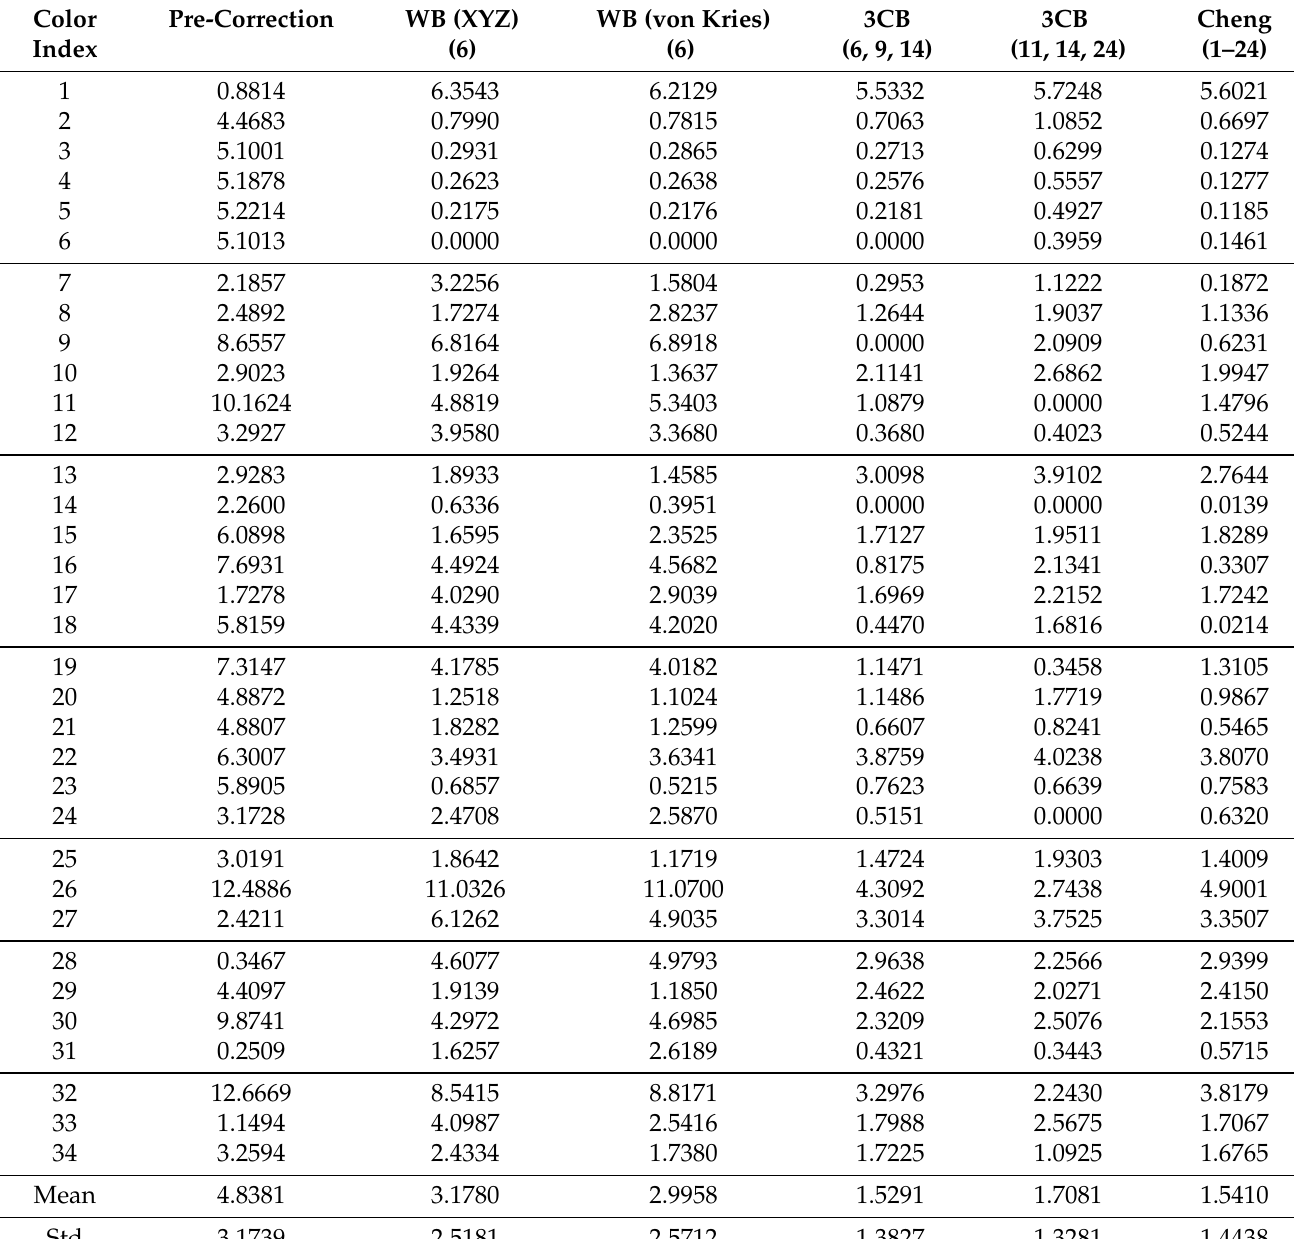
Table 3. Reproduction angular error ( Err ) for every object (deg) in Figure 7c. Color indices correspond to those in Figure 7. Indices inside () indicate target colors used in each